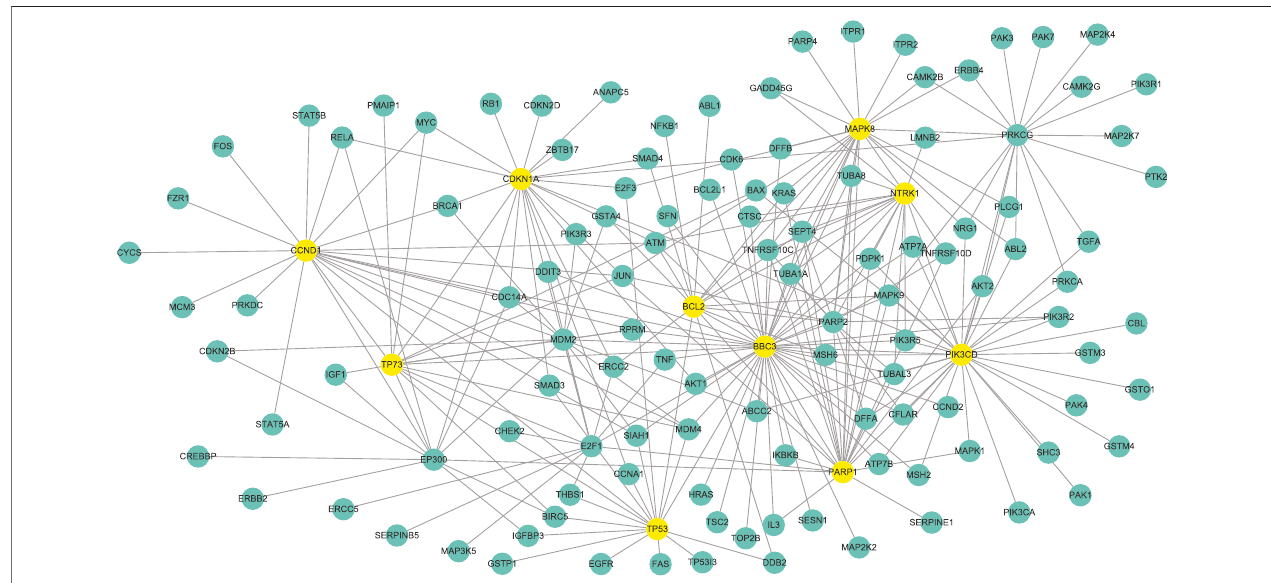
FIGURE 4 | The differential network between platinum-resistant and platinum-sensitive tumors identi fi ed by WJSDM. Here, yellow nodes denote the top-10 hub genes in the differential network.